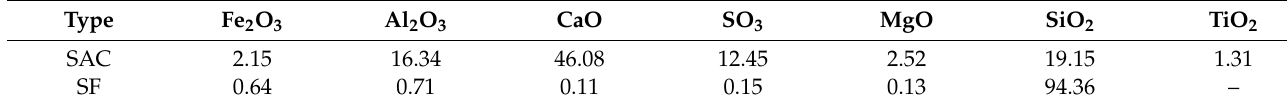
Table 1. Chemical compositions of SAC and SF (wt%).